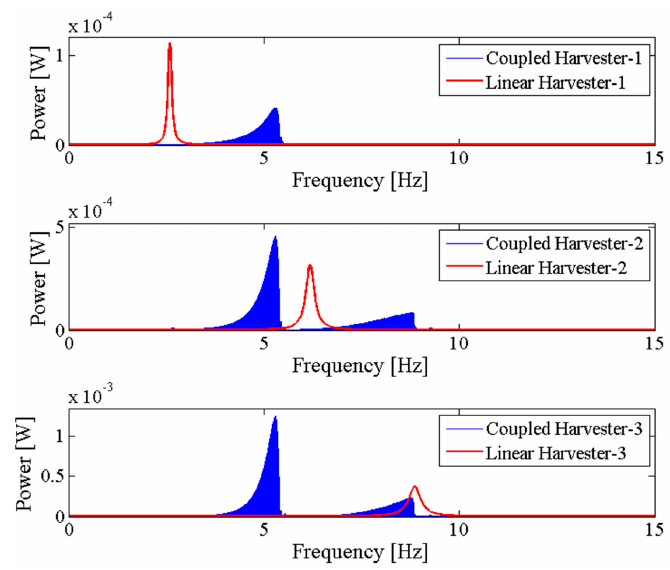
Figure 11. Output power of the NPEHS-2. Sensors 2018 , 18 , x FOR PEER REVIEW